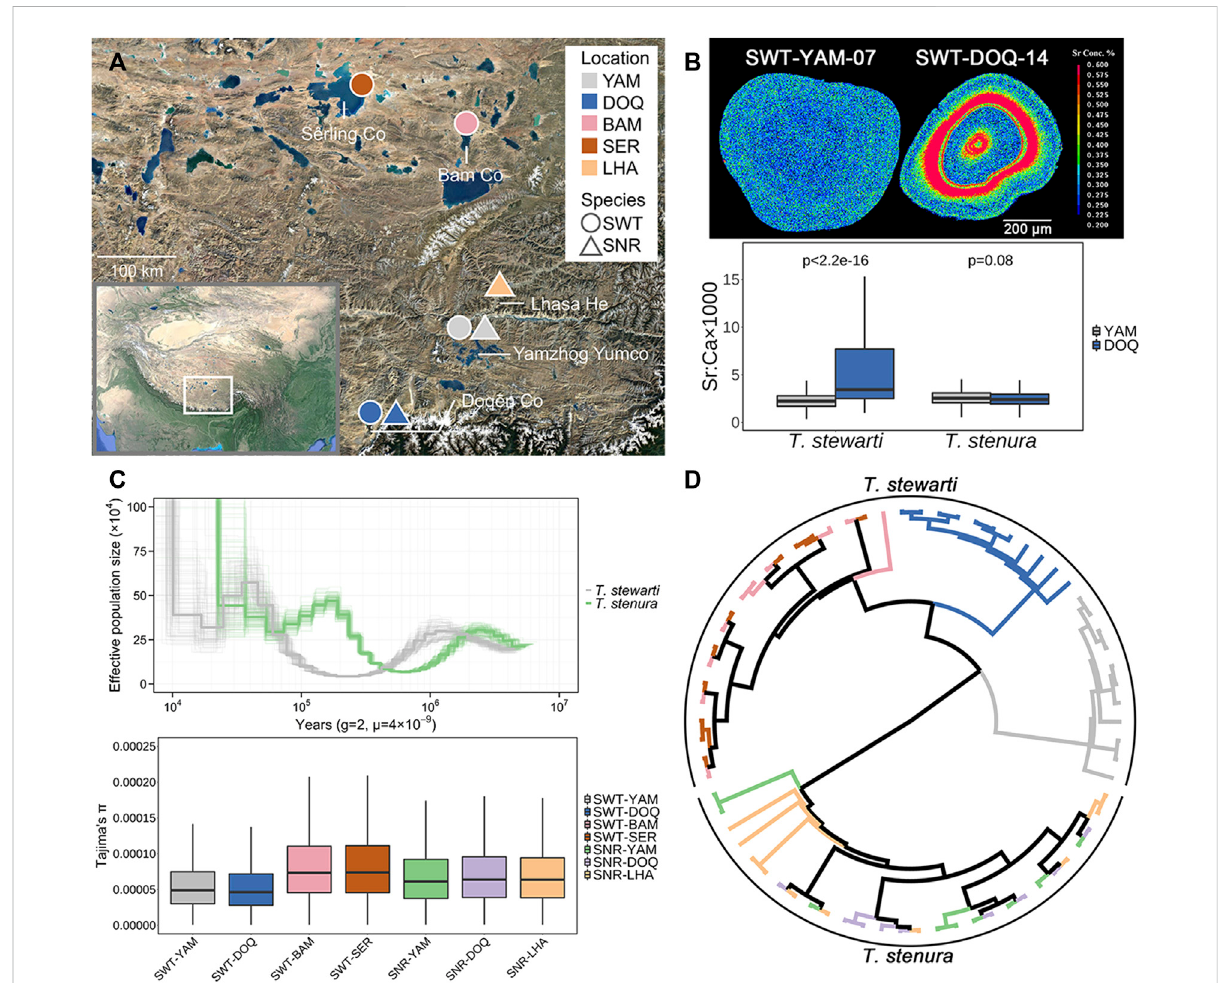
FIGURE 1 (A) Sampling sites in this study. SWT, T. stewarti ; SNR, T. stenura ; YAM, Lake Yamzhog Yumco; DOQ, Lake Doq ē n Co; BAM, Lake Bam Co; SER, Lake Sêrling Co; LHA, River Lhasa He. (B) Top panel: two-dimensional imaging of Sr concentrations using otolith EPMA mapping analyses (SWT-YAM-07 and SWT-DOQ-14 taken as examples). Sr concentrations are represented by 16 colors, from red (highest) to green to blue (lowest). Bottom panel: comparisons of otolith Sr:Ca ratios along line transects from the core to the edge between Lake Yamzhog Yumco and Lake Doq ē n Co populations of the two Triplophysa species. The signi fi cance test was complemented using the Wilcoxon Rank Sum Test with continuity correction. (C) Top panel: effective population size changes of T. stewarti and T. stenura estimated using PSMC. Thick lines represent population size inferences, and thin lines represent 100 bootstraps. Bottom panel: genetic diversity (Tajima ’ s π ) of each population. (D) IQ-TREE reconstructed using the “ common ” SNP dataset. The color of each branch corresponds to the population in C (bottom